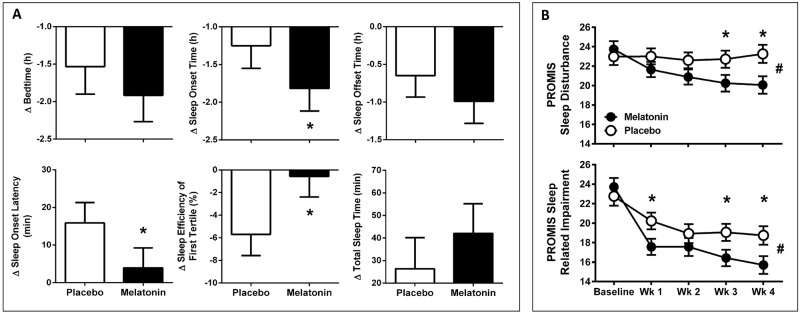
Change in actigraphic sleep parameters and subjective sleep quality and sleep-related impairment under treatment with melatonin and placebo.(A) Predicted change (mean ± 95% CIs) from baseline to treatment phase in actigraphic sleep parameters for individuals during treatment with placebo (open) and 0.5 mg melatonin (closed) (intention-to-treat analyses). Predicted values are derived from regression analyses to account for intra- and inter-individual variability. *P < 0.05. (B) Subjective measures of PROMIS Sleep Disturbance (upper) and PROMIS Sleep Related Impairment (lower) (n = 116) at baseline and weeks 1–4 treatment with placebo (open symbols) and melatonin (closed symbols). Data are mean ± SE. *P < 0.05 for post hoc between groups t test; #P < 0.05 for treatment group x time. CI, confidence interval; PROMIS, Patient Reported Outcomes Measurement Information System; SE, standard error.